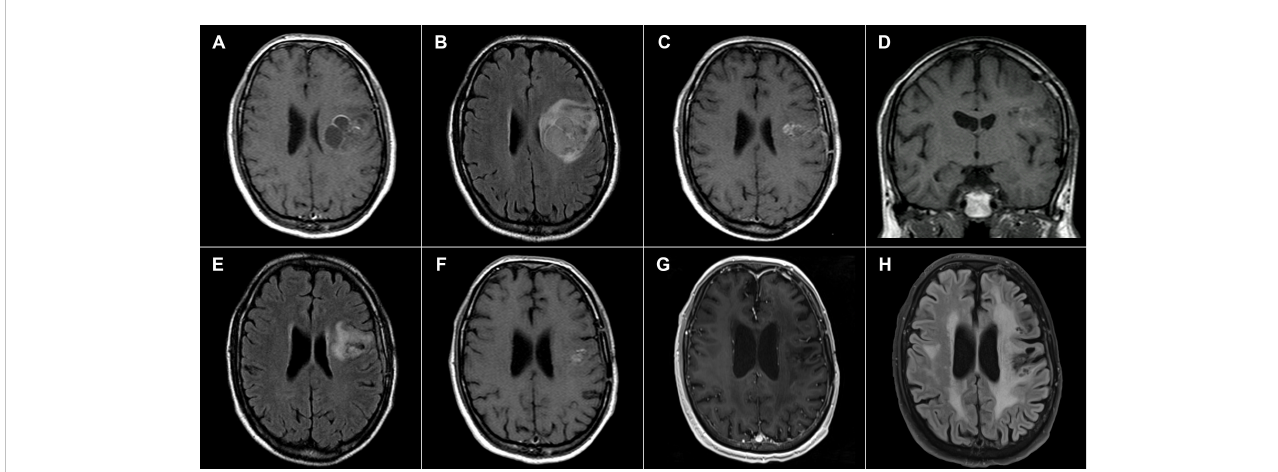
FIGURE 1 43-year-old male. (A) January 2004, 1 Tesla scanner: T1-weighted postcontrast spin echo preoperative image showing a GBM in the left central region. (B) Corresponding FLAIR image. (C) July 2004, 1 Tesla scanner: T1-weighted postcontrast spin echo postoperative image with a residual enhancing tumor after a partial resection (D) T1-weighted pre-contrast spin echo image from the same examination with minimal hyperintense signal at the border of the lesion (E) Corresponding FLAIR image. (F) August 2005 1 Tesla scanner: T1-weighted postcontrast spin echo image showing a decrease of the postcontrast enhancement suggesting a residual tumor regression. (G) May 2022, 3 Tesla scanner: T1-weighted postcontrast MP-RAGE sequence 217 months after surgery with no signs of residual tumor or its recurrence showing dystrophic and atrophic changes (H) Corresponding FLAIR image with dystrophic and post-radiation